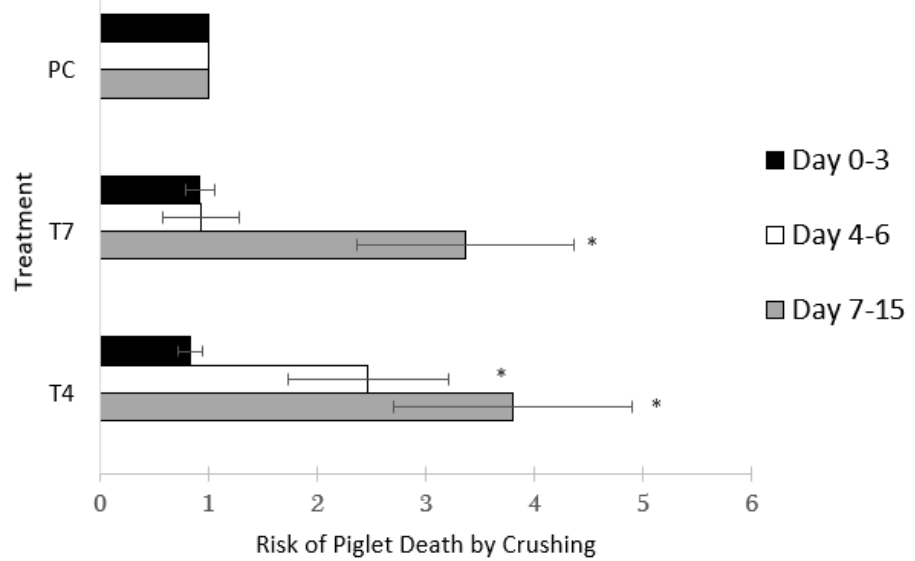
Figure 2. Effect of treatment on the relative risk (95% CI) of piglet death from being laid on, for three different periods: day 0 to 3, where all treatments had the farrowing crates closed, day 4 to 6, where the day 4 group had their crate opened, and days 7 to 15, where both the 7 day and 4 day group had their crates opened but before any litters had been early weaned. Treatment groups are denoted as PC, sow permanently crated until weaning, T4, sows crated until the fourth day post-farrowing, and T7, sows crated until the seventh day post-farrowing. Values marked by an asterisk are statistically different from PC group (p < 0.05) for that time period. Table 3. Percentage of piglet mortality (mean ± SD) due to being laid on across different periods post farrowing by treatment group.